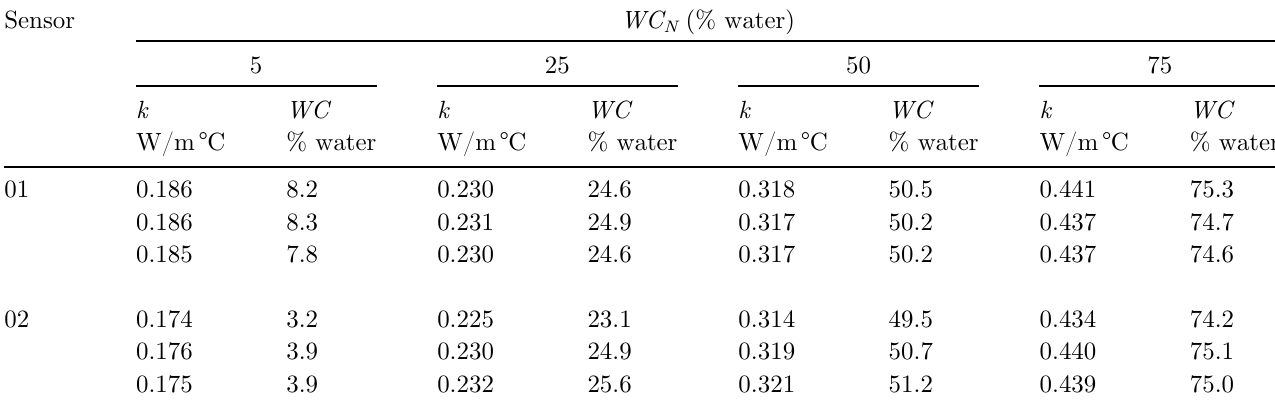
Table 6. Water content of the binary mixtures of water and ethanol at 20 ° C.